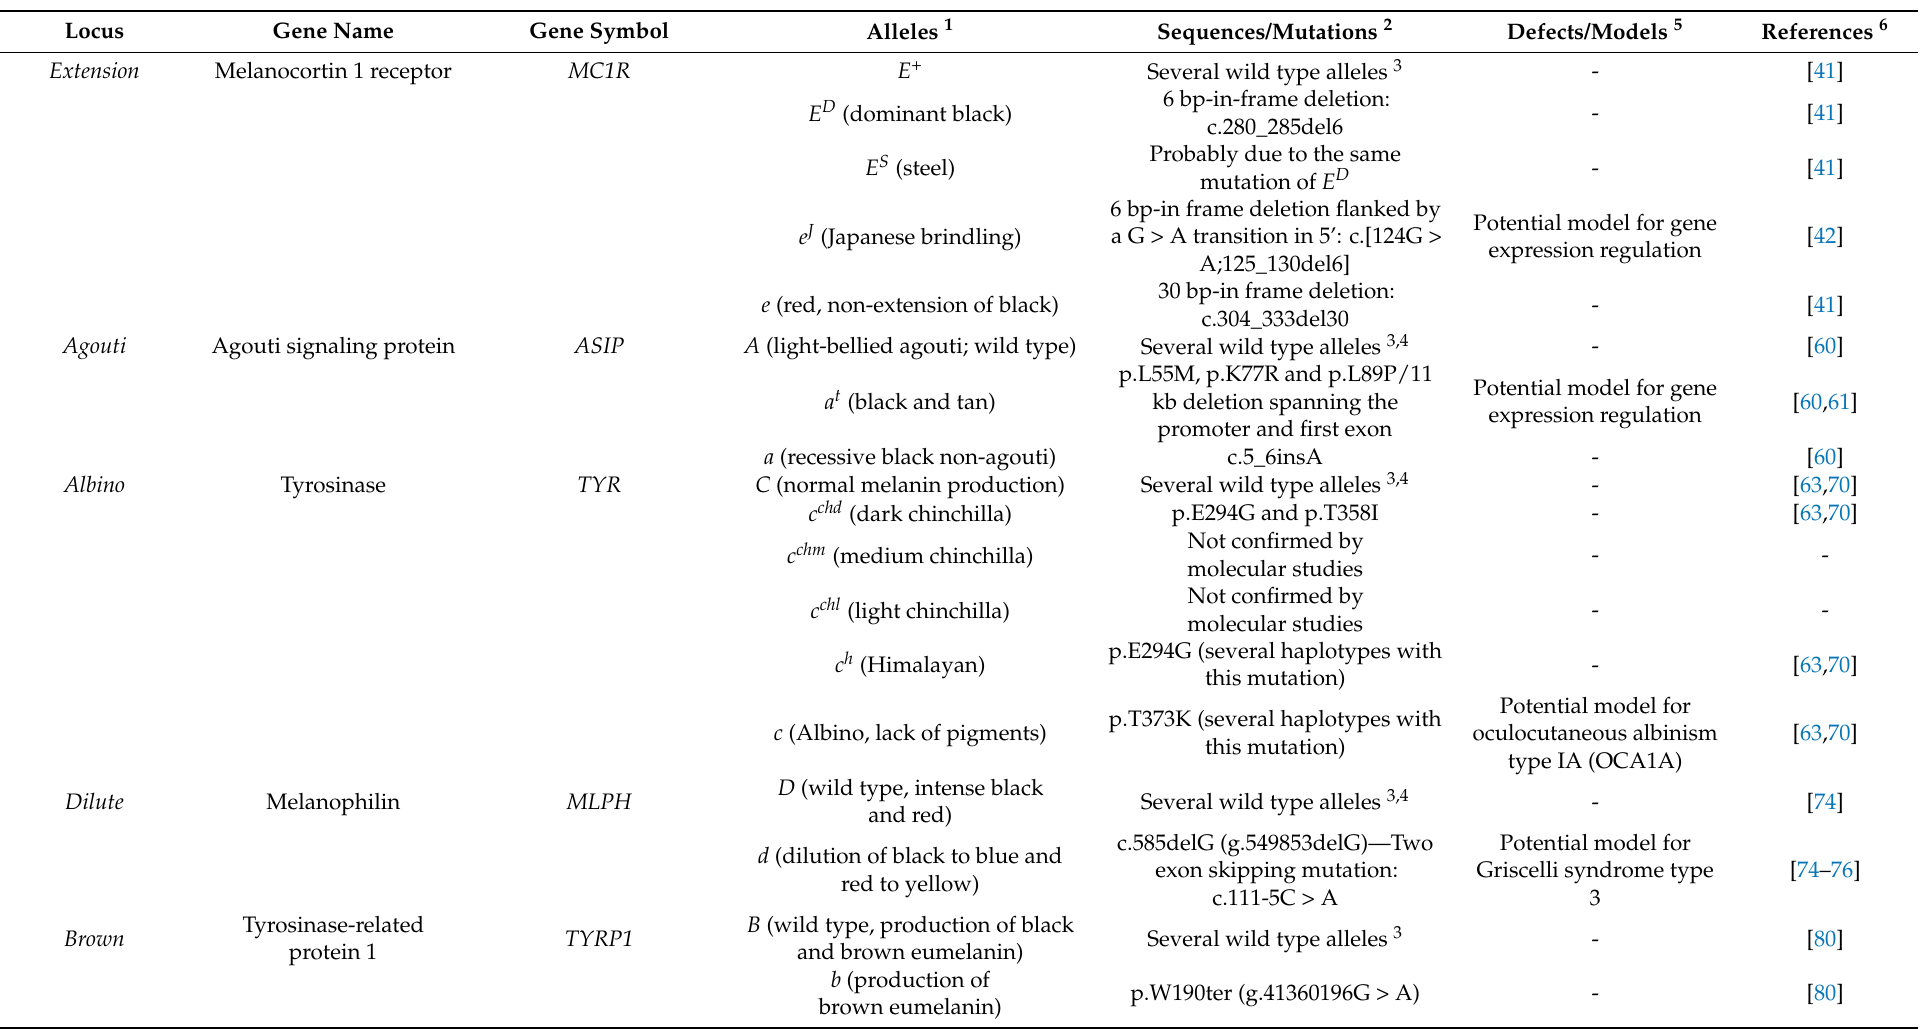
Table 1. Rabbit loci that have been characterized or partially described at the molecular level, corresponding mutations, and potential biomedical models of the related mutants.